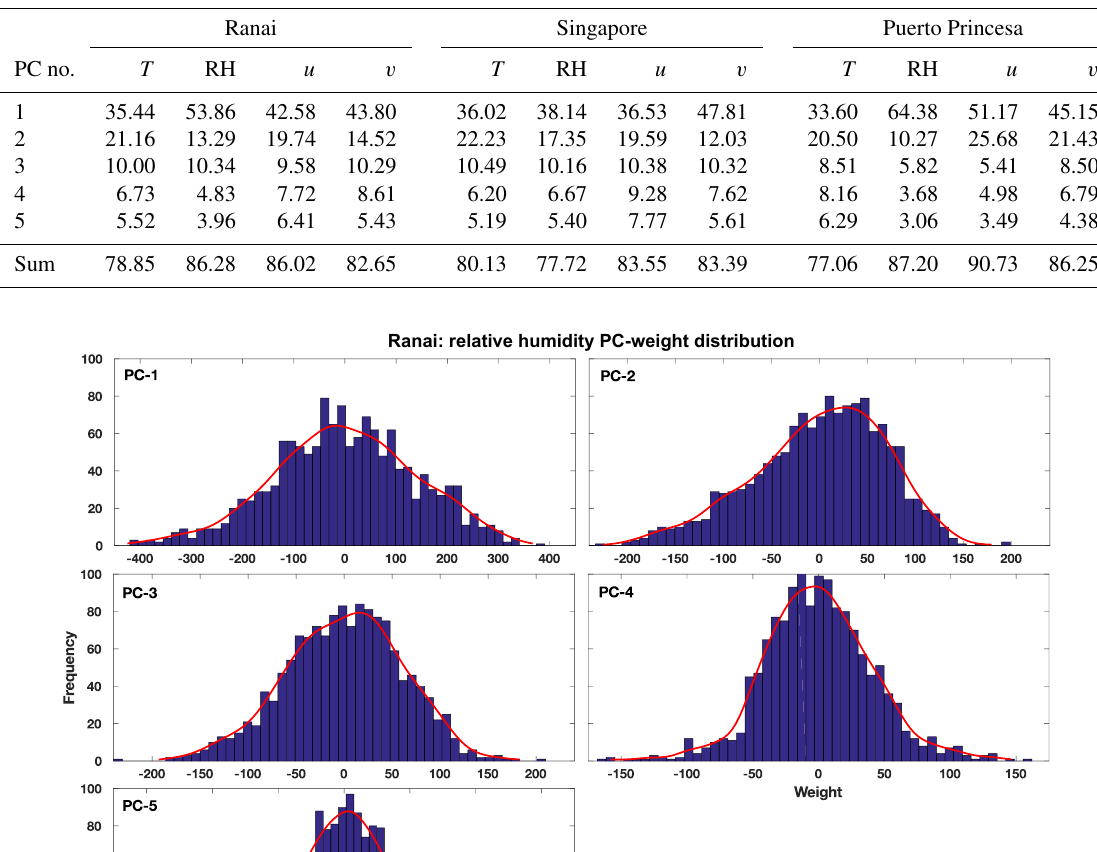
Table 3. Percent of total variance explained for each variable’s PCs from the three upper-air sounding sites. The first PC represents the highest variance and each subsequent component explains a decreasing amount of the residual variance. Percent variance explained by principal components Ranai Singapore PC no.